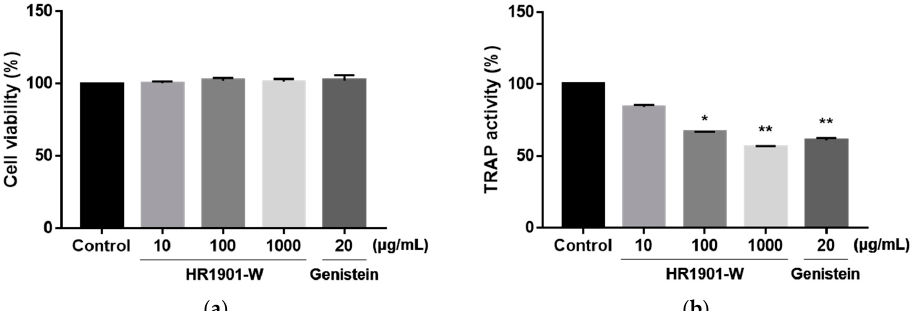
Figure 3. Effects of HR1901-W on the protein expression levels of alkaline phosphatase (ALP), osteocalcin (OCN), and runt-related transcription factor 2 (Runx2) in MC3T3-E1 cells. Respective immunoblot images of the protein expression levels of ALP, OCN, and Runx2 affected by HR1901-W. Relative protein levels of ALP, OCN, and Runx2 densitometrically quantified with β -actin in HR1901-W-treated MC3T3-E1 cells ( a – c ). As a positive control, 20 μ g/mL of genistein was used. All values are expressed as the mean ± standard deviation. * p < 0.05, ** p < 0.01, and *** p < 0.001 when compared with the control.